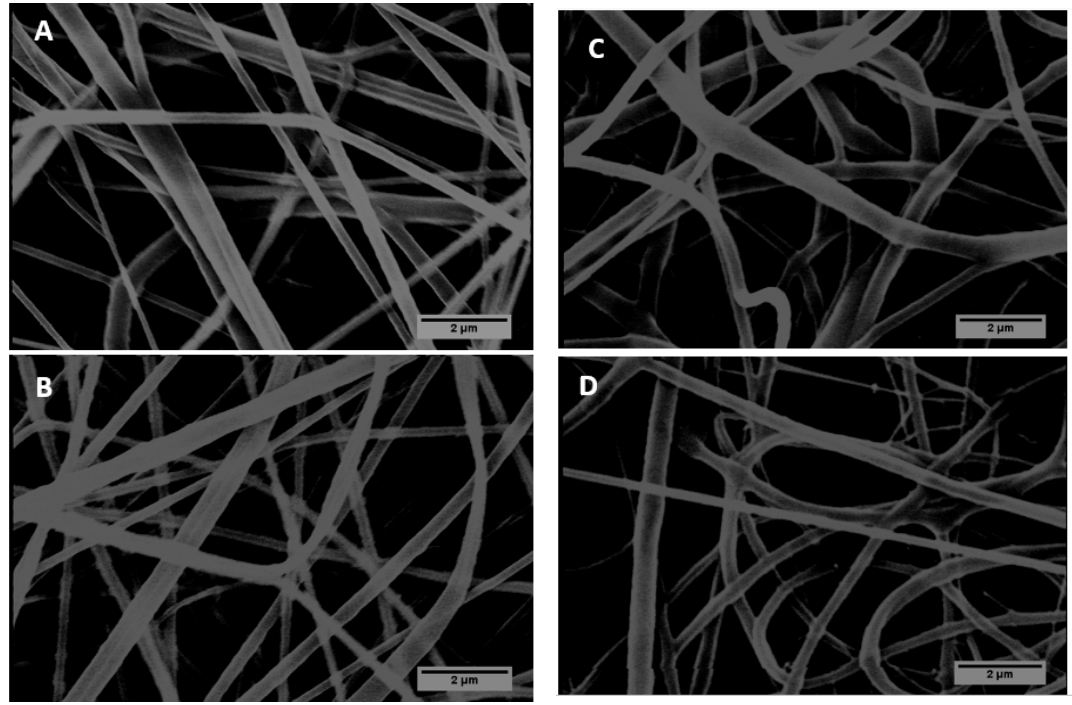
Figure 3. SEM images of the PCL/gelatin/P188 (85:10:5 %w/v) composite nanofibers electrospun at ( A ) 18 kV, ( B ) 20 kV, ( C ) 22 kV, and ( D ) 24 kV voltages. The images were measured at a magnification of ×9000 to ×10,000.